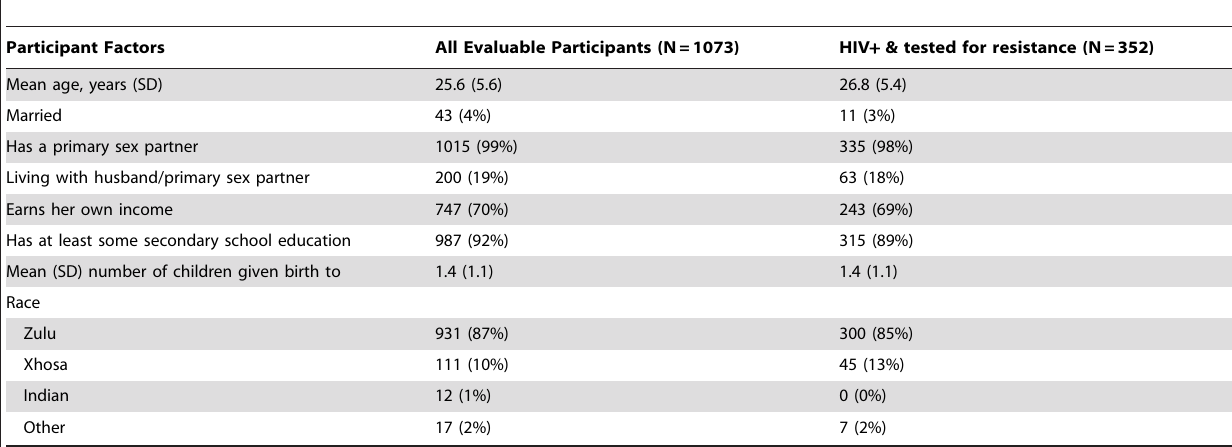
Table 1. Demographic Factors for All Evaluable Participants and the Subset that was HIV Positive and Tested for Drug Resistance in MTN-009.